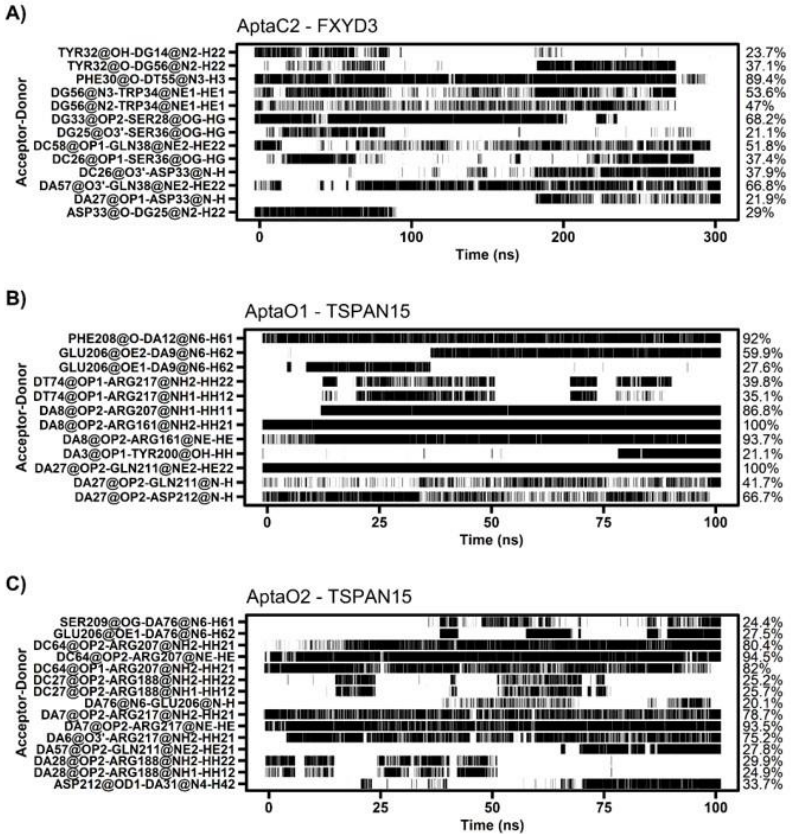
Figure 12. Hydrogen bond between protein and aptamer of each system. ( A ) AptaC2-FXYD3; ( B ) AptaO1-TSPAN15; ( C ) AptaO2-TSPAN15. The occupancy of each interaction is on the right